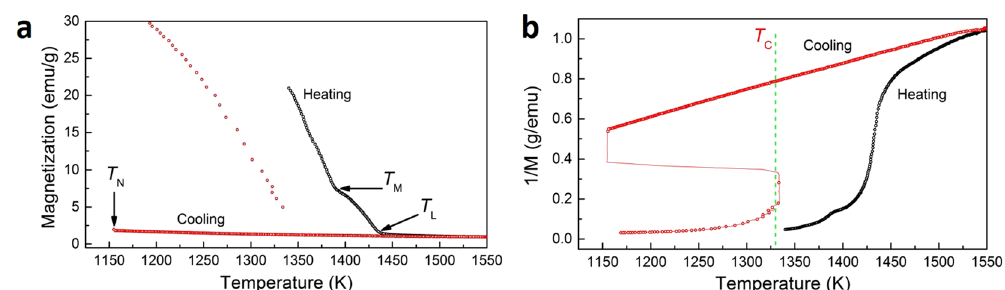
Figure 6. ( a ) Magnetization as a function of temperature curves and ( b ) Inverse Magnetization as a function of temperature curves of Co 76 Sn 24 near eutectic alloy measured in 93 T/m gradient magnetic field and the field intensity is 6.23 T at the sample